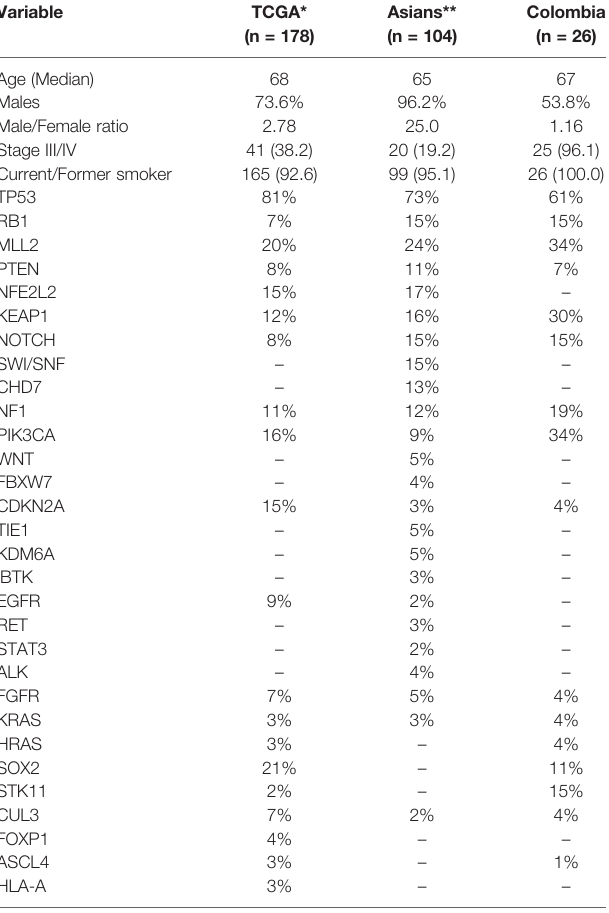
TABLE 3 | Comparison of the clinical and molecular characteristics between lung SCC from the TCGA (16), Korean (18), and Colombian cohorts.